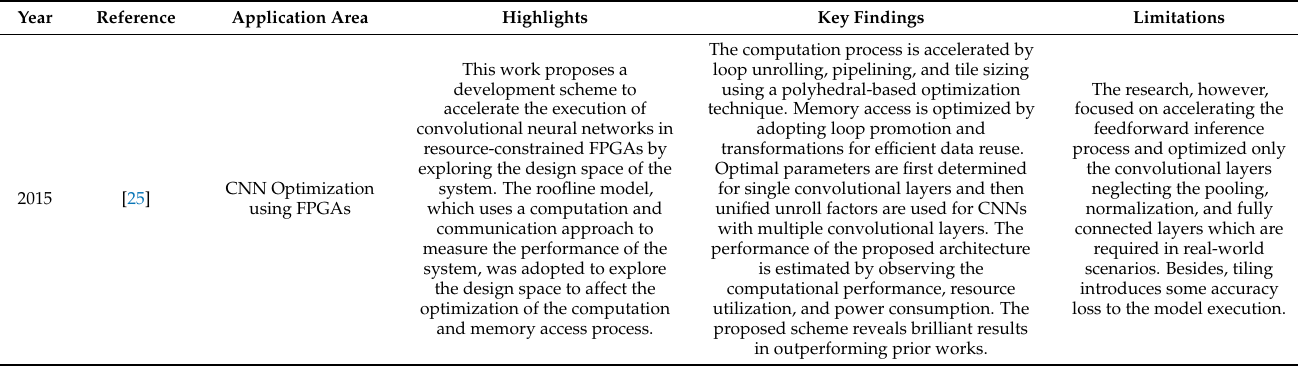
Table 22. Embedded FPGAs: optimization and